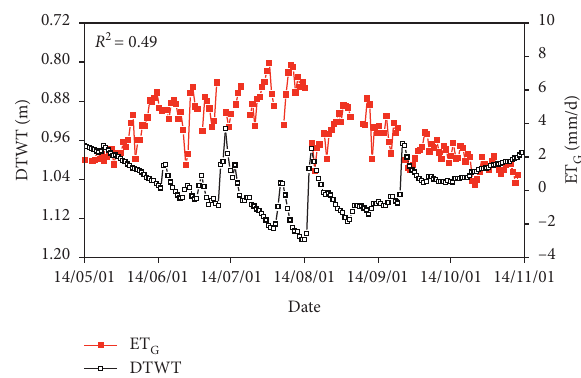
Figure 9: Estimated daily groundwater evapotranspiration (ET of observation site G6 and the depth to water table (DTWT) in the growing season in